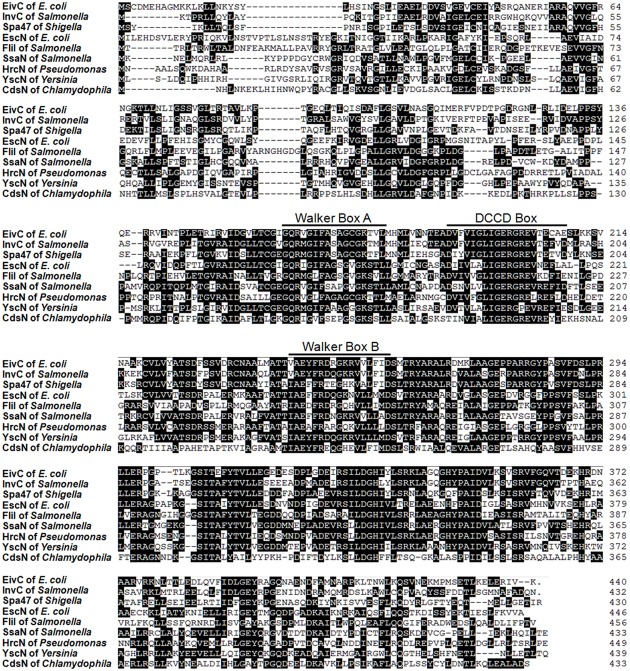
Sequence analysis of ETT2 and EivC. Amino acid sequence comparisons of EivC with other T3SS ATPases. The locations of predicted Walker boxes A and B and a dicyclohexylcarbodiimide-binding site (DCCD box) within the amino acid sequence of EivC are indicated.